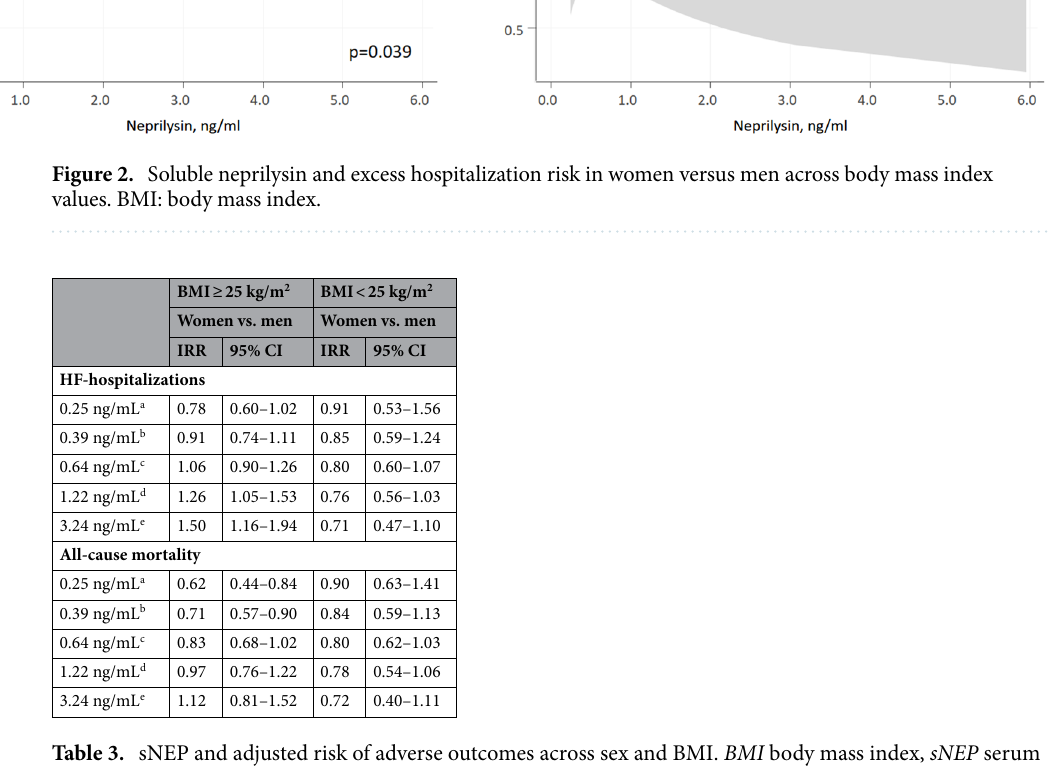
Table 3. sNEP and adjusted risk of adverse outcomes across sex and BMI. BMI body mass index, sNEP serum neprilysin. a Percentile 10% of sNEP distribution. b Percentile 25% of sNEP distribution. c Percentile 50% of sNEP distribution. d Percentile 75% of sNEP distribution. e Percentile 90% of sNEP